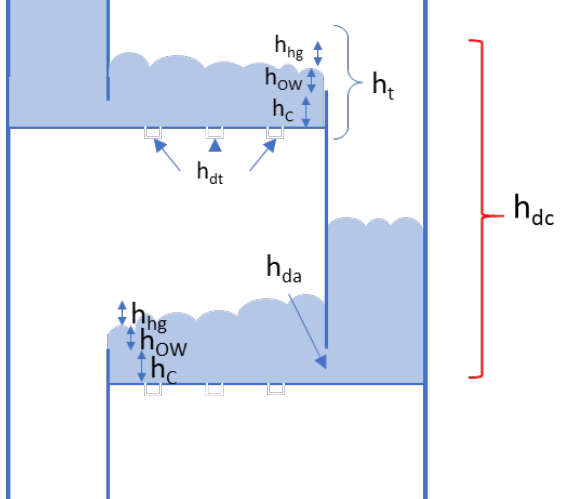
Figure A2. Overview of the pressure drop/liquid height components that determine the downcomer backup.